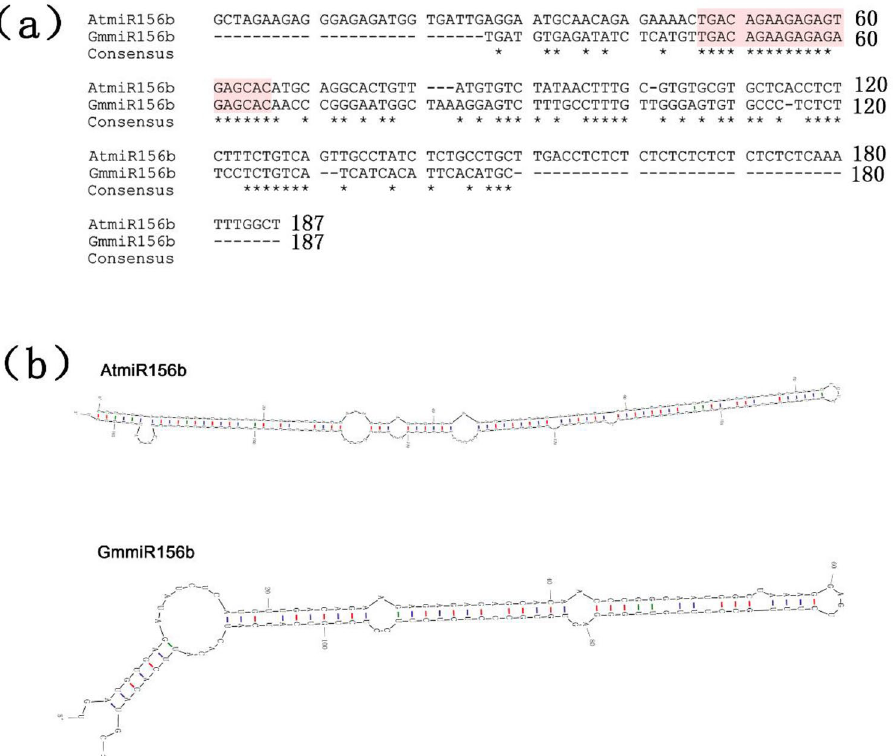
Figure 1. Comparison of miR156b in Arabidopsis and soybean. ( a ) DNA sequence alignment of miR156b precursors from Arabidopsis ( AtmiR156b ) and soybean ( GmmiR156b ). The mature gene sequences were highlighted in pink. ( b ) Secondary structure of miR156b